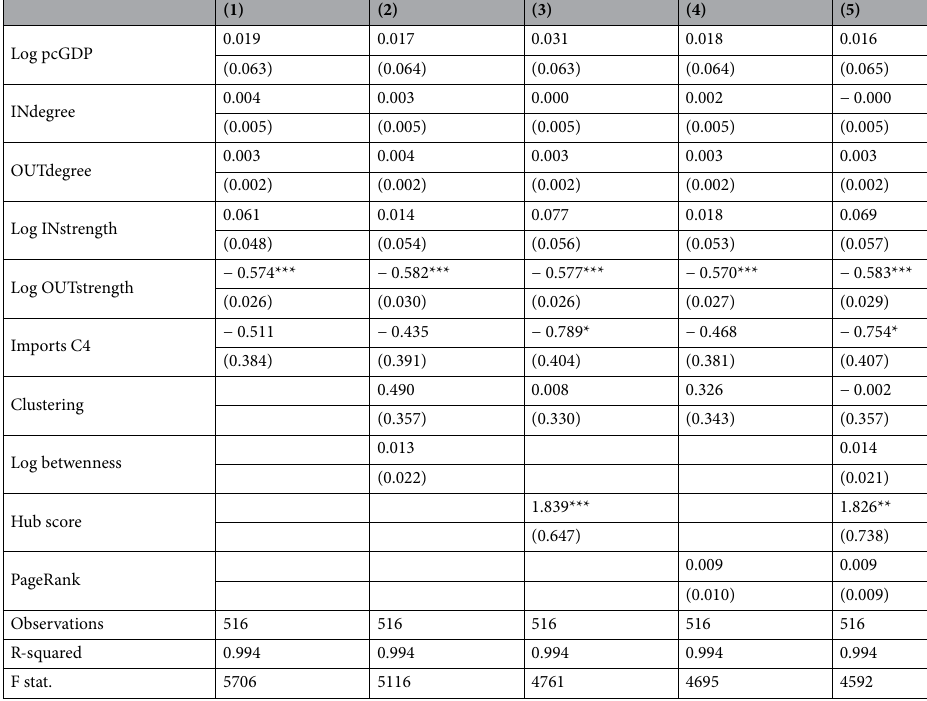
Table 3. Vulnerability analysis: OLS regression of ranking. The table reports the results on the OLS regressions in which the dependent variable is countries’ ranking in terms of vulnerability to external shocks (higher values in the ranking are associated with higher vulnerability). The ranking is based on the results of a set of 3 N simulations that reproduce, one at the time and for all the countries in the network, the propagation of shock associated to a 30% drop of domestic food production and a value of α equal to 0, 0.5, and 1. Dummies for α ∈ ( 0, 0.5, 1 ) not shown. Clustering and PageRank measures have been multiplied by 1,000. Robust